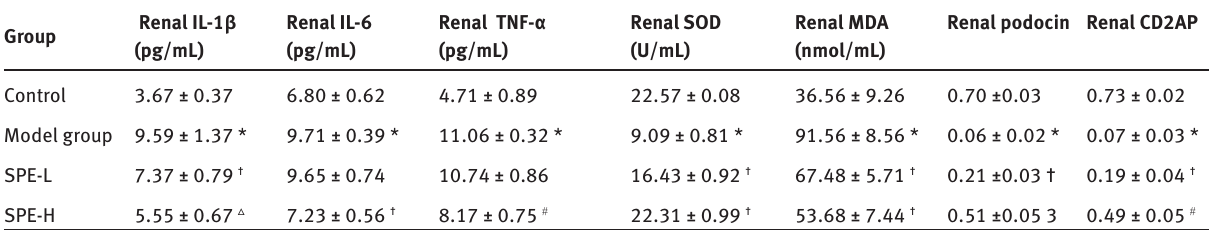
Table 5: Regulatory effects of SPE on renal IL-1β, IL-6, SOD, MDA, podocin and CD2AP